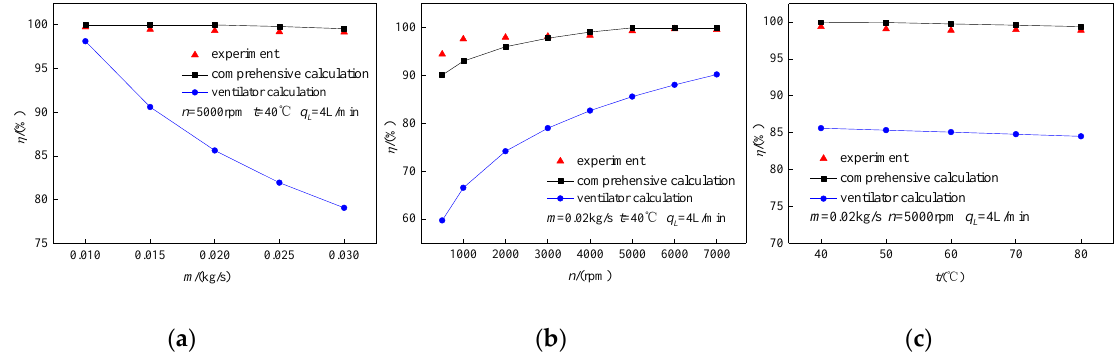
Figure 7. Separation efficiency. ( a ) Ventilation rate; ( b ) rotating speed; ( c ) temperature.